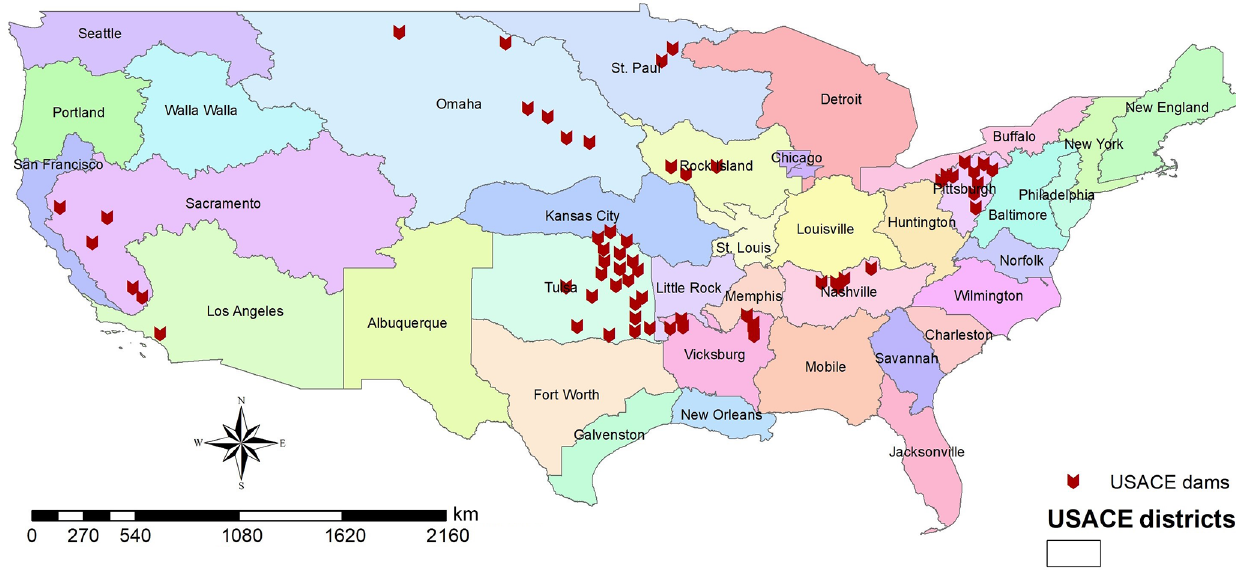
Figure 1. USACE districts and location of reservoirs in this study.